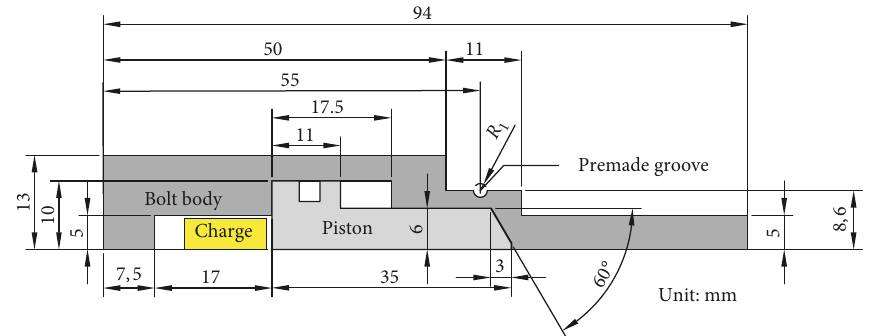
Figure 7: Simplified physical model of the explosive bolt.